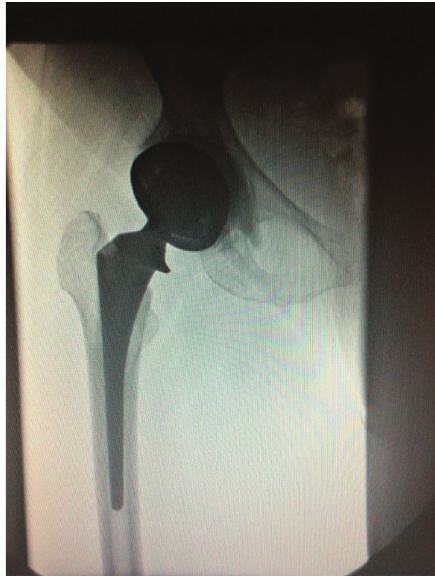
Figure 3. Fluoroscopic examination of a dual mobility THR.